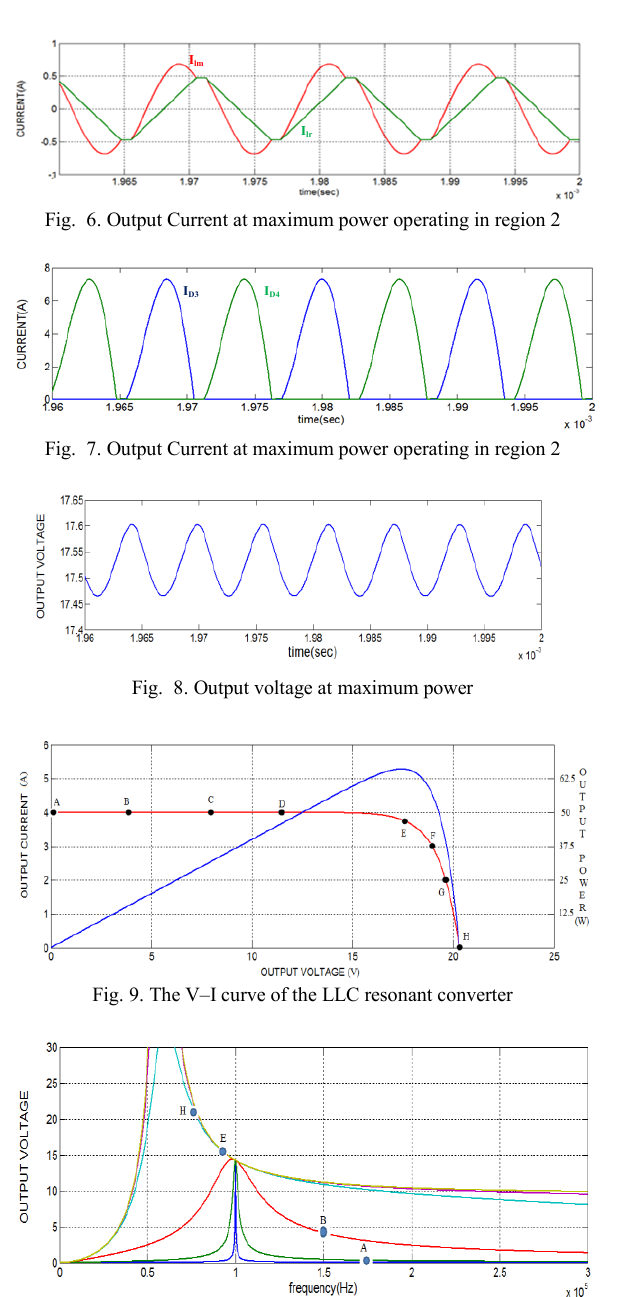
Fig. 10. Frequency response of output voltage gain